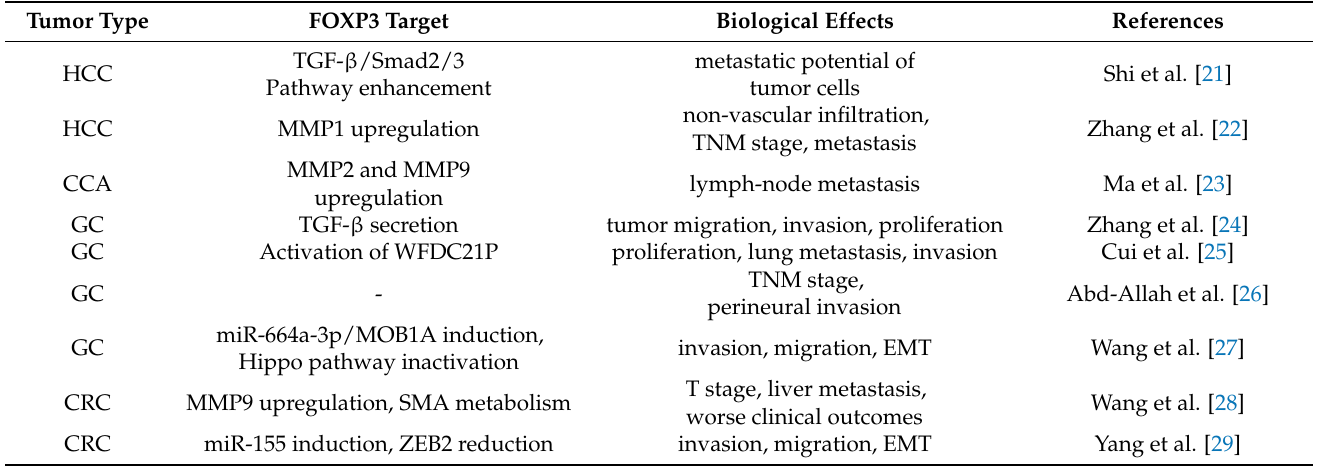
Table 2. FOXP3 acts as a promoter in digestive system